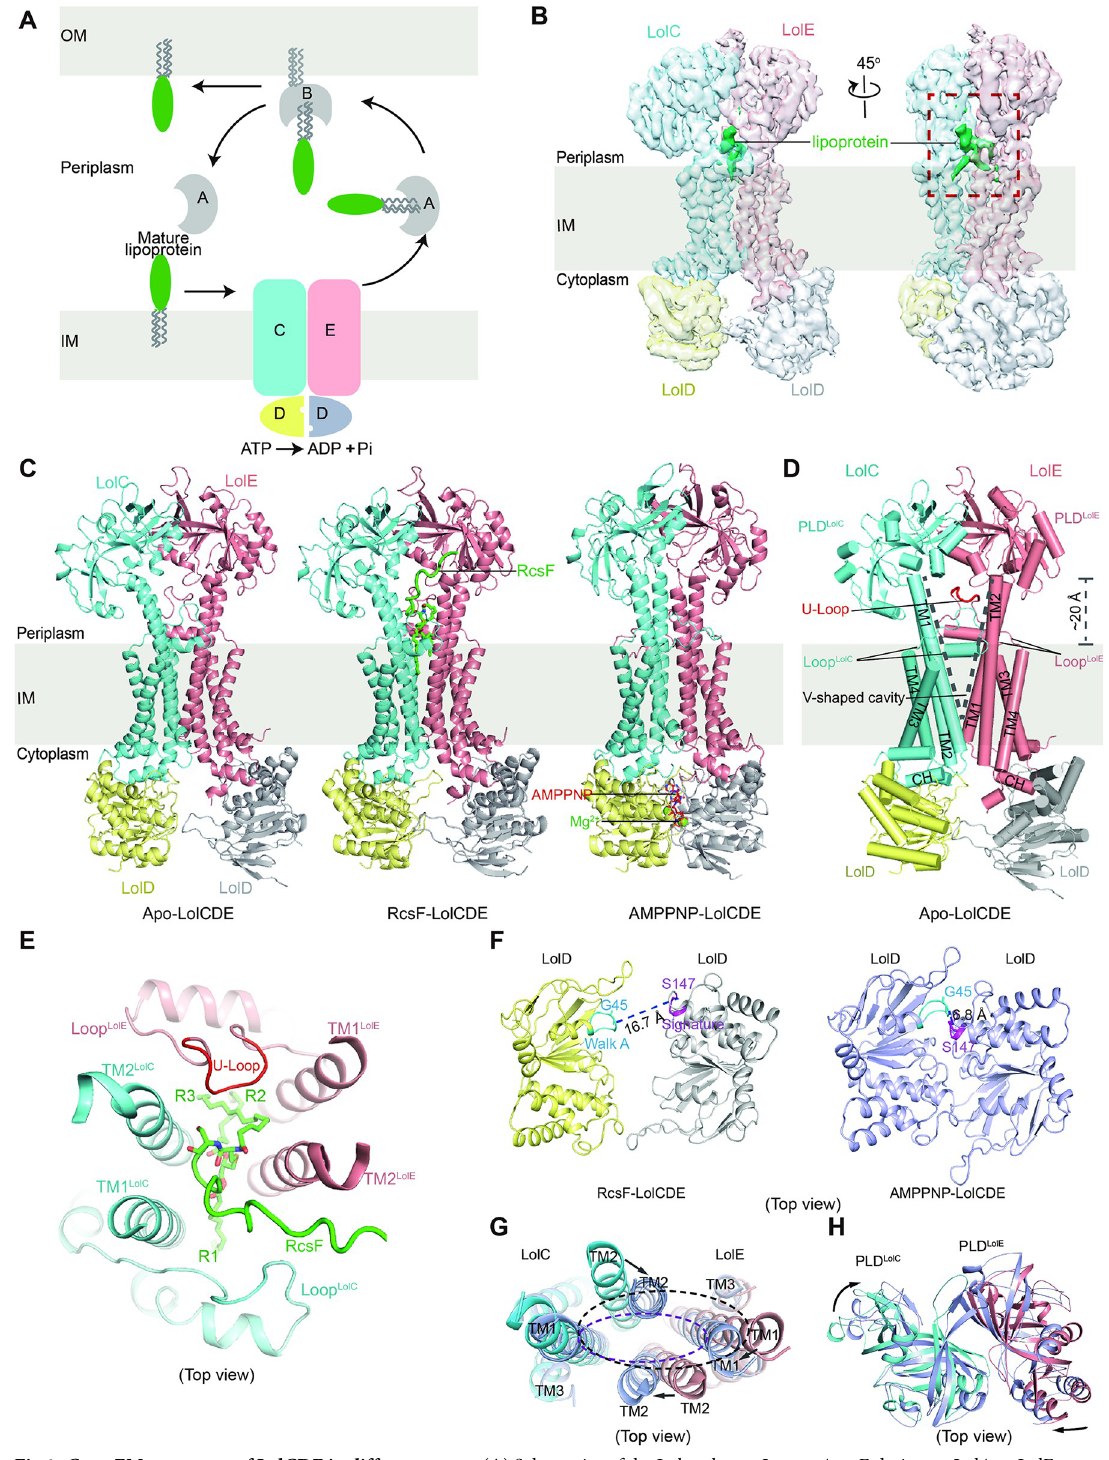
Fig 1. Cryo-EM structures of LolCDE in different states. ( A ) Schematics of the Lol pathway. Letters A to E designate LolA to LolE, respectively. ( B ) The 4.0- Å cryo-EM map of LolCDE. LolC, LolE and 2 copies of LolD are colored in blue, pink, yellow, and grey, respectively. The lipoprotein densities are shown in green. ( C ) Ribbon diagram of apo, RcsF-bound and AMPPNP-bound LolCDE structures. Mg 2+ is shown in green spheres and AMPPNP in red sticks. ( D ) Cylindrical helix cartoon representation of structure motifs of apo-LolCDE. The U-Loop is highlighted in red. Dashed lines indicate the V-shaped cavity of LolCDE. ( E ) Top view of the